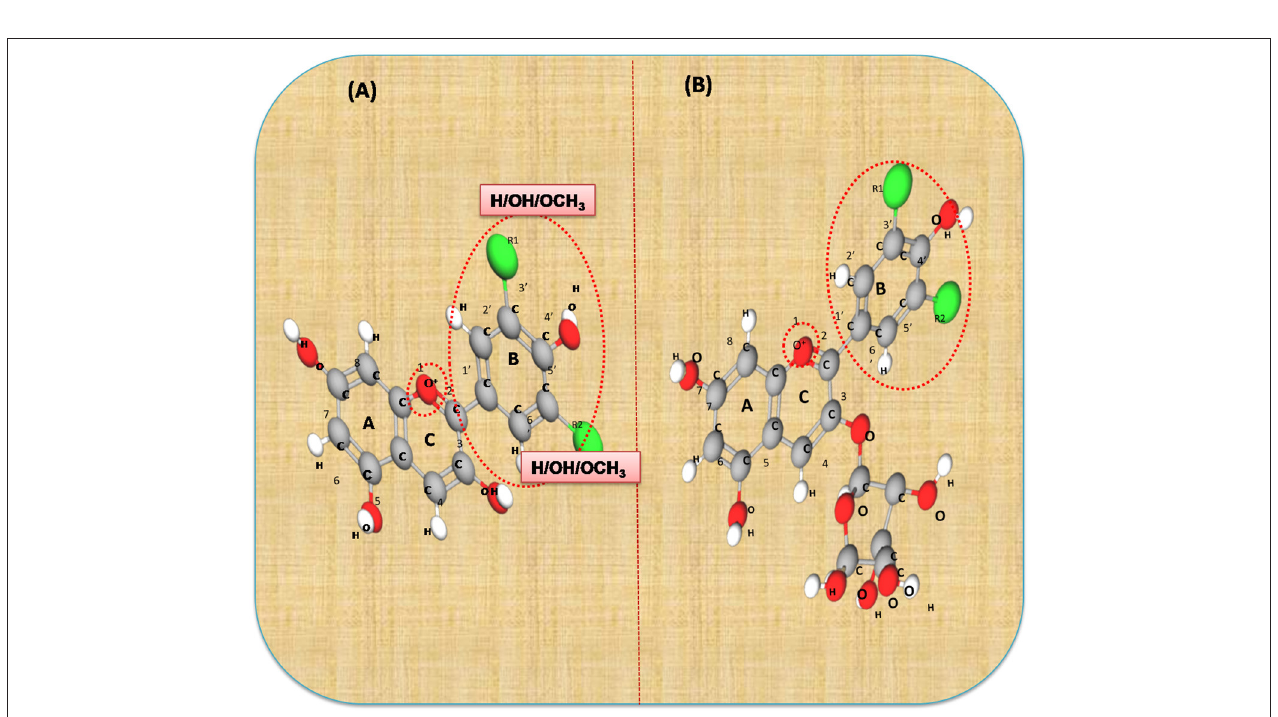
FIGURE 2 | The basic structure of anthocyanidin (A) and anthocyanin-3-glucoside (B) . Anthocyanins comprise hydroxyl or methoxyl group on the B-ring of flavylium ion. The B-ring and positive charge at the oxygen atom of the C-ring (red dotted circles) is reactive which makes the anthocyanin molecule a strong antioxidant.